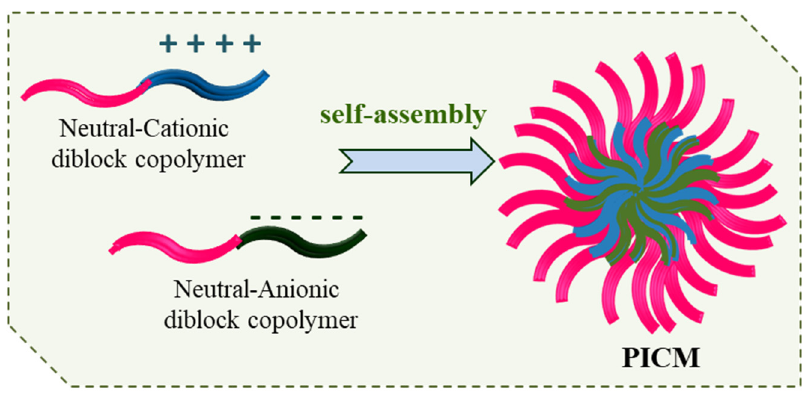
Figure 11. PICMs self-assembly from oppositely charged polyelectrolytes.